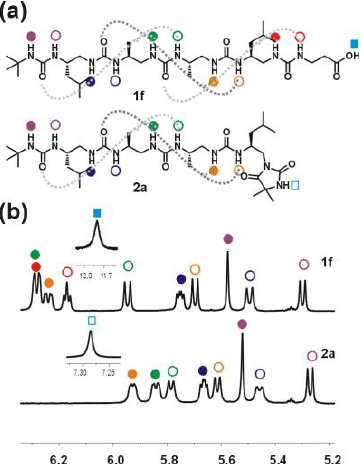
Figure 3. ( a ) Structures of compounds 1f and 2a , with grey curves showing the scheme of intramolec- ular hydrogen bonds of the 2.5 helix. ( b ) Parts of the 1 H NMR spectra (500 MHz) of compounds 1f and 2a in 10% DMSO-d 6 in CD 3 CN (3 mM) showing the NH/N’H region. It is well known that the differences in the chemical shifts ( ∆ δ ) of CH 2 protons